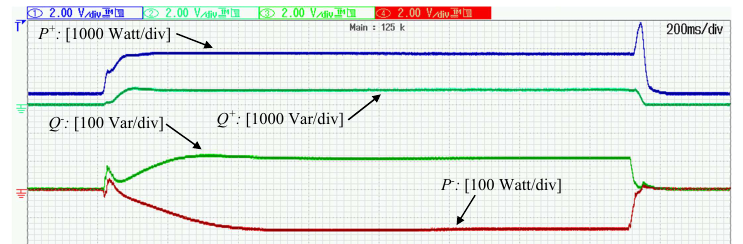
Figure 6. Operation under single-phase voltage drop ( V ga = 0.35p.u.): Injected powers.